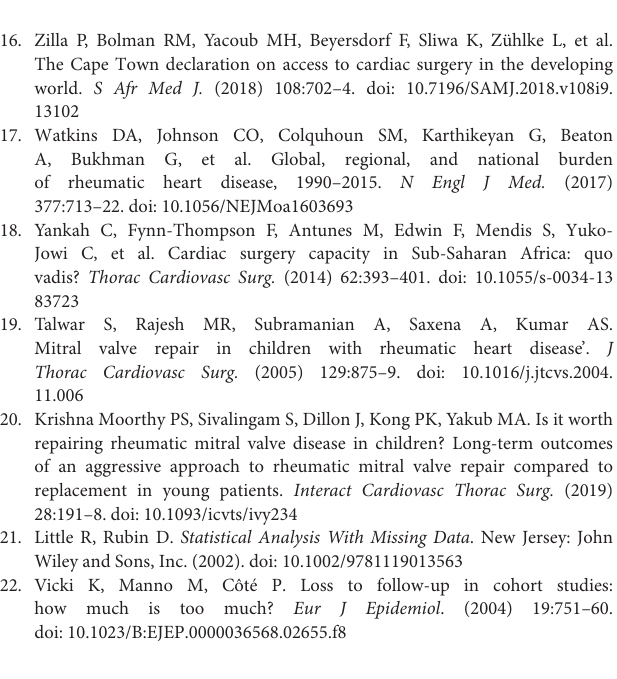
Supplementary Figure 1 | Study flow chart. Supplementary Figure 2 | Year-by-year numbers of operated children (under 15), divided by disease. Supplementary Table 1 | The Salam Centre Working Group